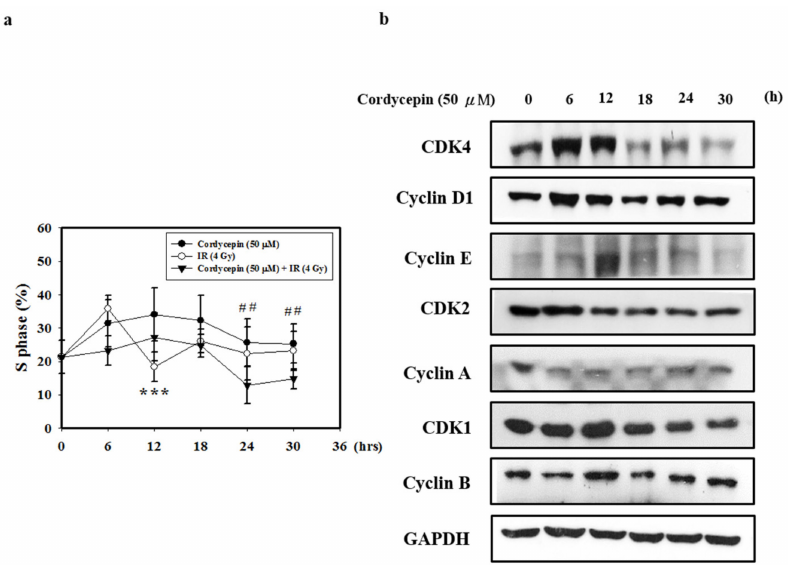
Figure 5. Cordycepin induces S phase arrest and regulates the expression of cell cycle regulatory proteins in IR- and cordycepin-treated SAS cells. ( a ) Quantification of S phase. Cells were treated with cordycepin (50 µ M) or IR (4 Gy) for 6, 12, 18, 24, and 30 h, and DNA content was analyzed by flow cytometry. *** p < 0.05, cordycepin versus IR. ## p < 0.05, cordycepin versus cordycepin + IR. ( b ) E ff ects of cordycepin and / or IR on the expression of CDK4, cyclin D1, CDK2, cyclin E, cyclin A, CDK1, and cyclin B proteins in SAS cells. The cells were treated with 50 µ M cordycepin for 0, 6, 12, 18, 24, and 30 h. After treatment, the CDK4, cyclin D1, CDK2, cyclin E, cyclin A, CDK1 and cyclin B proteins were detected by Western